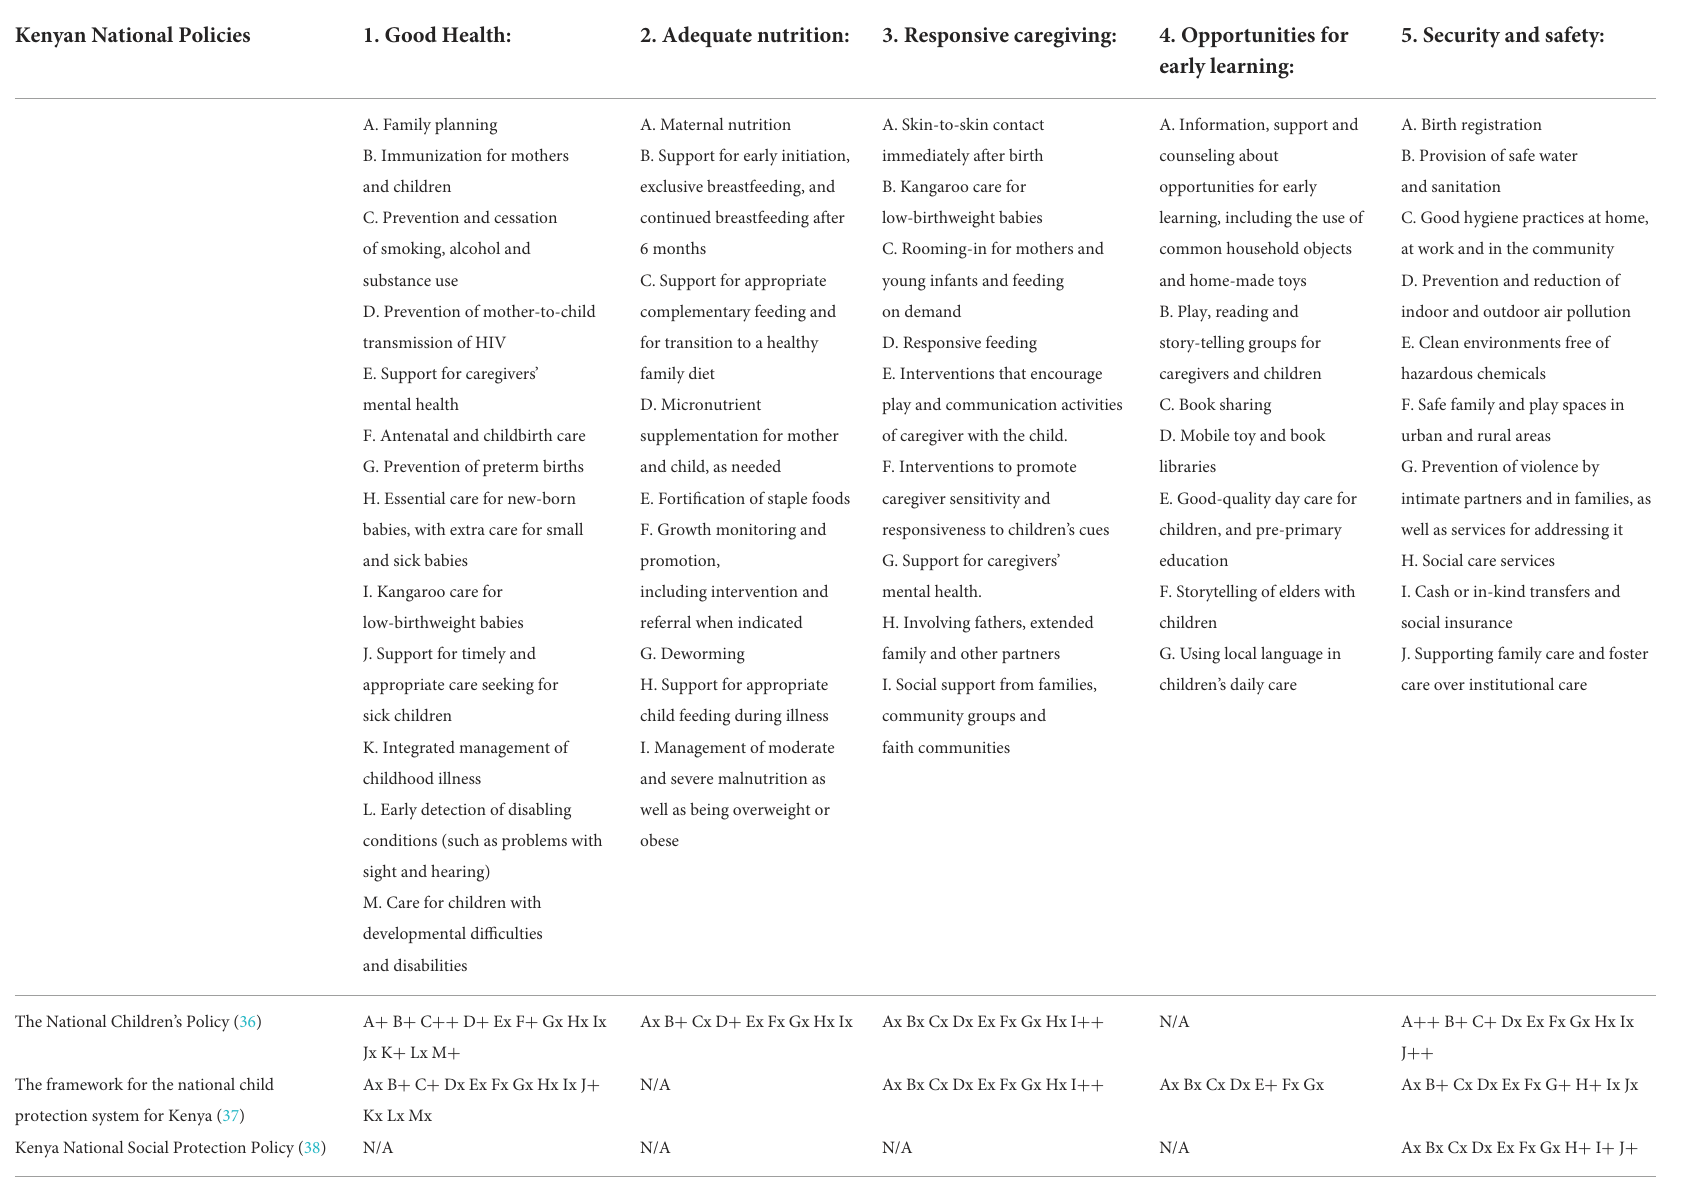
TABLE 2 National policy documents data coding table. Kenyan National